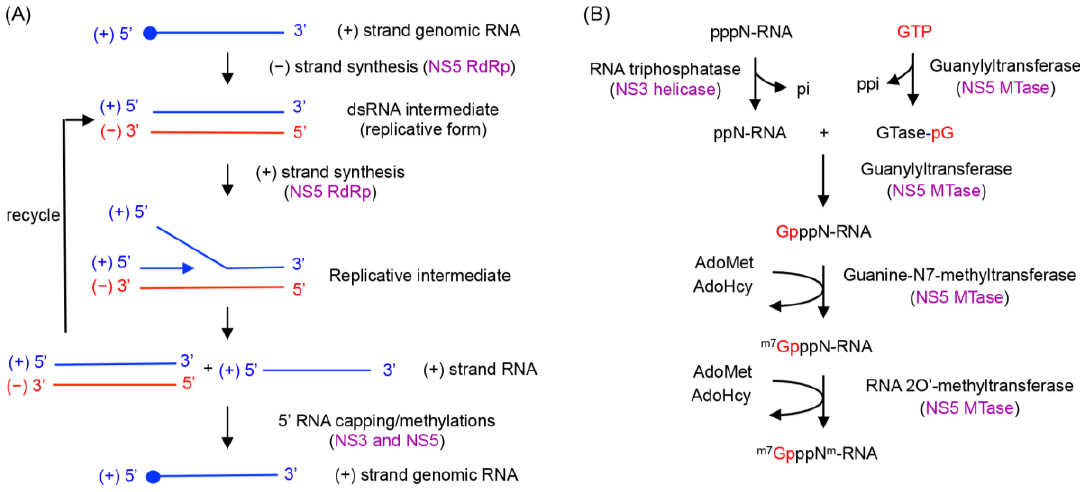
Figure 1. RNA synthesis by the flavivirus replication complex. ( A ) RNA replication by RNA synthesis by the flavivirus replication